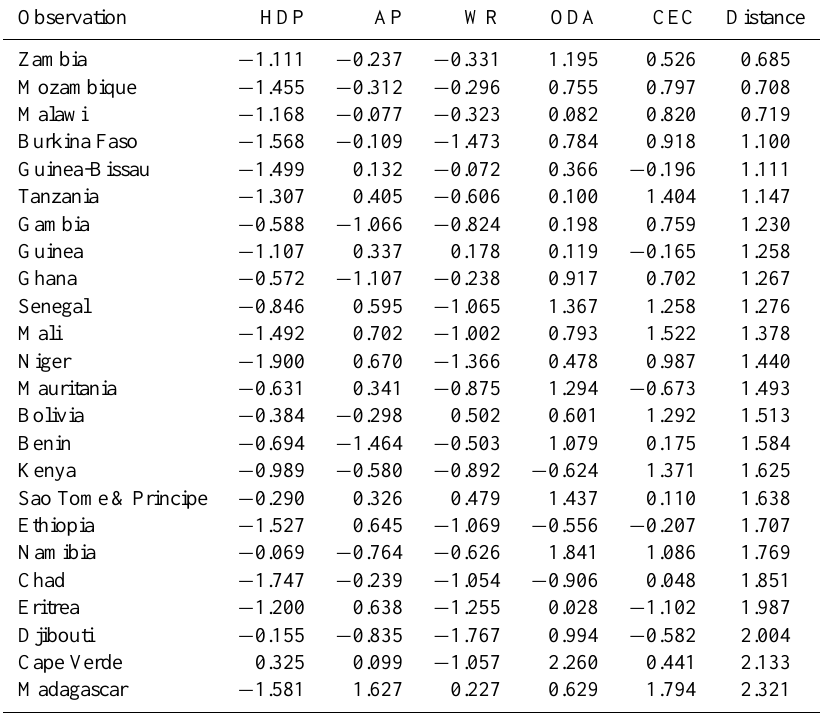
Table 10. Factors loadings and distances to average for profile 4. The last 5 countries of the list are considered outliers of the cluster, showing divergence with the average value of the